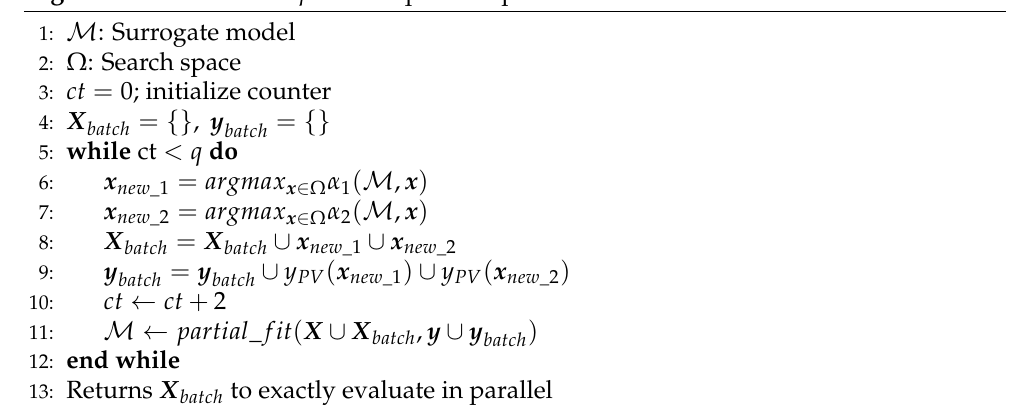
Algorithm 2 Multi-infill q -EGO acquisition